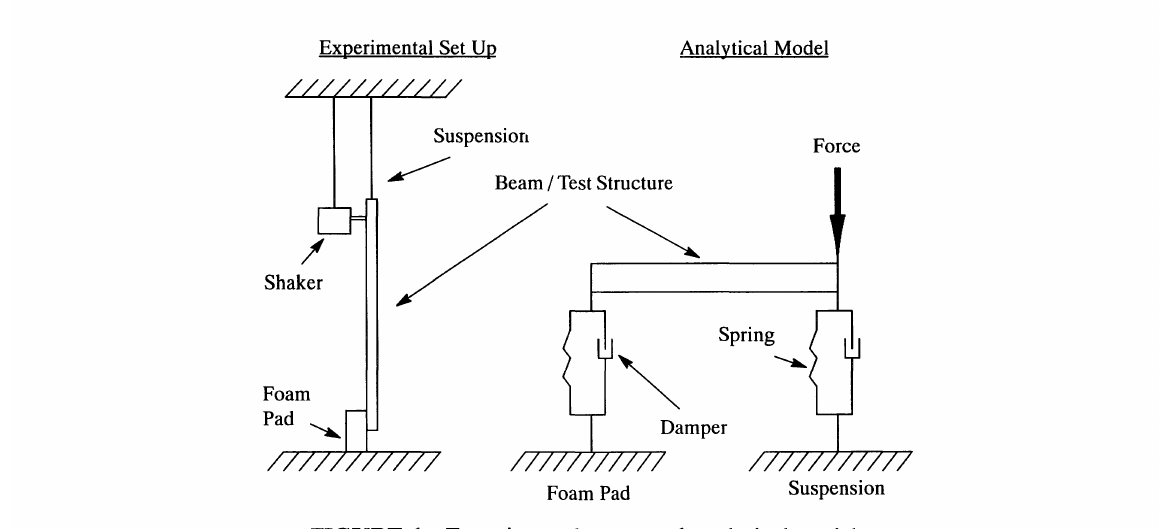
FIGURE 1 Experimental setup and analytical